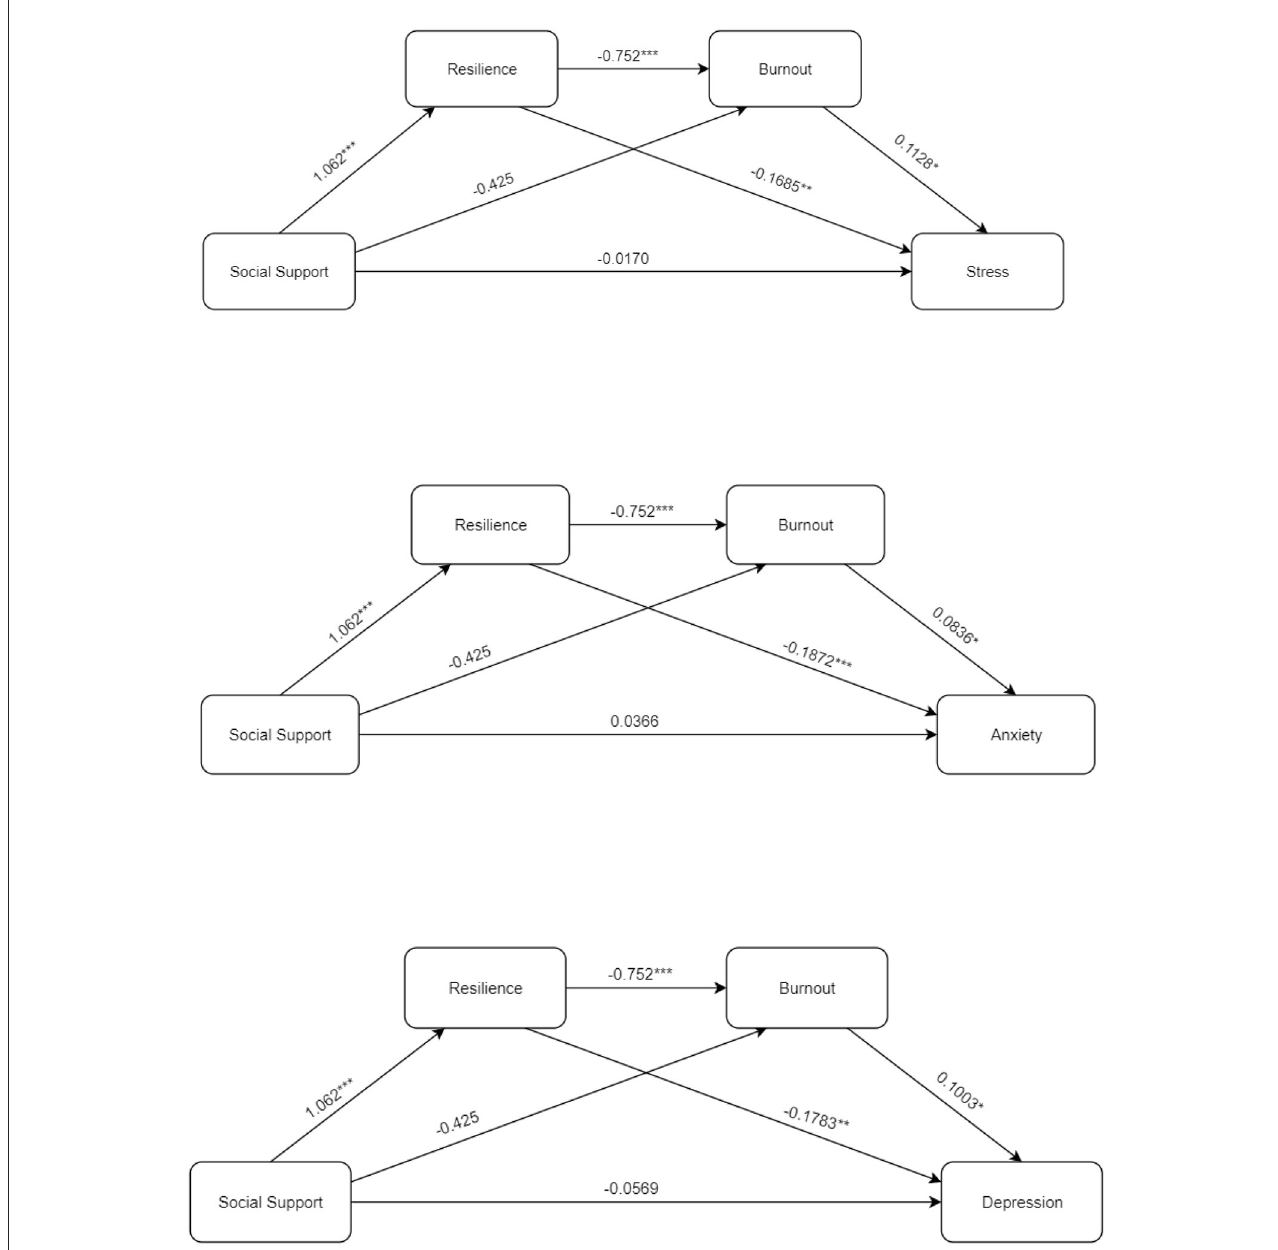
FIGURE1 Beta values from the mediating effect analysis (*** p < 0.001; ** p < 0.01; * p <